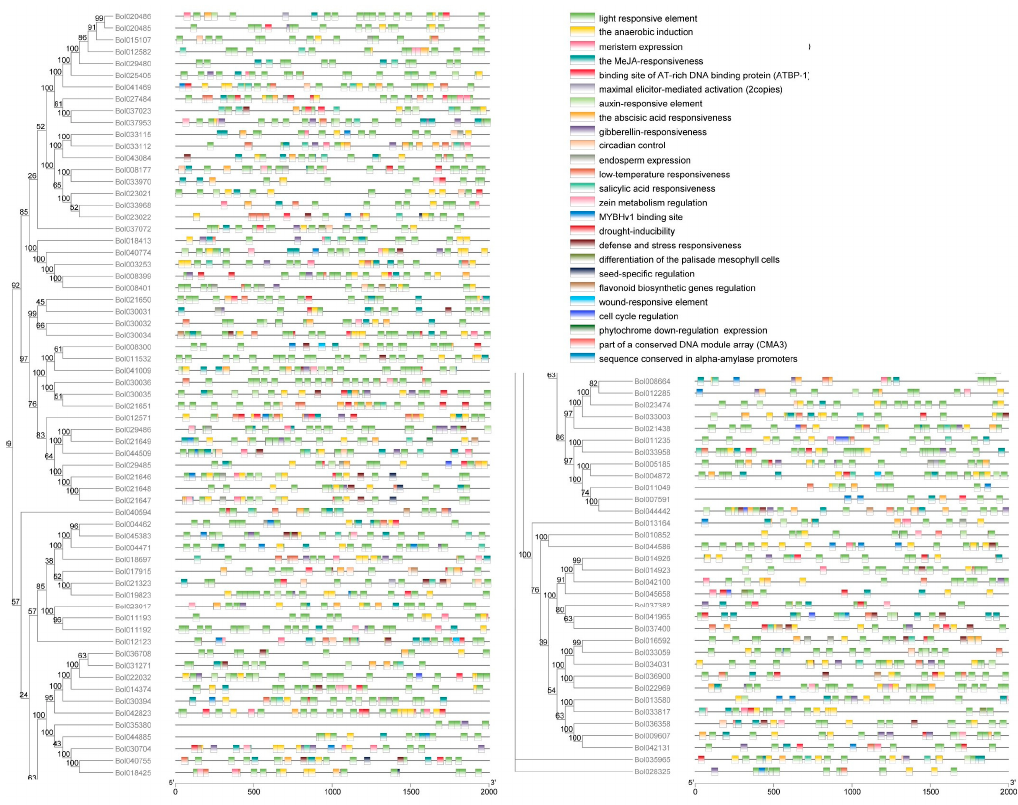
Figure 6. The cis-acting elements predication in the 2 kb sequences upstream of the “ATG” of the BoPGs. The types of elements are marked by di ff erent background